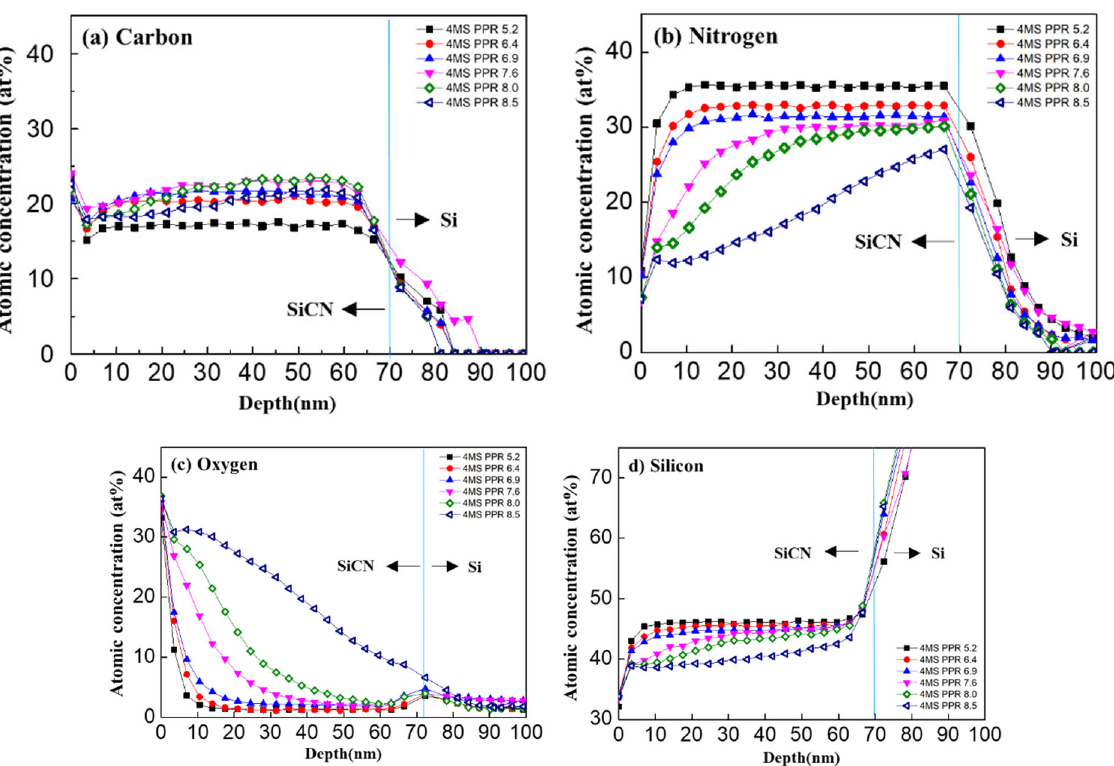
Figure 9. The concentration of components in the depth profile of the thin SiCN film through XPS analysis after HAST. ( a ) Carbon, ( b ) nitrogen, ( c ) oxygen, and ( d ) silicon.